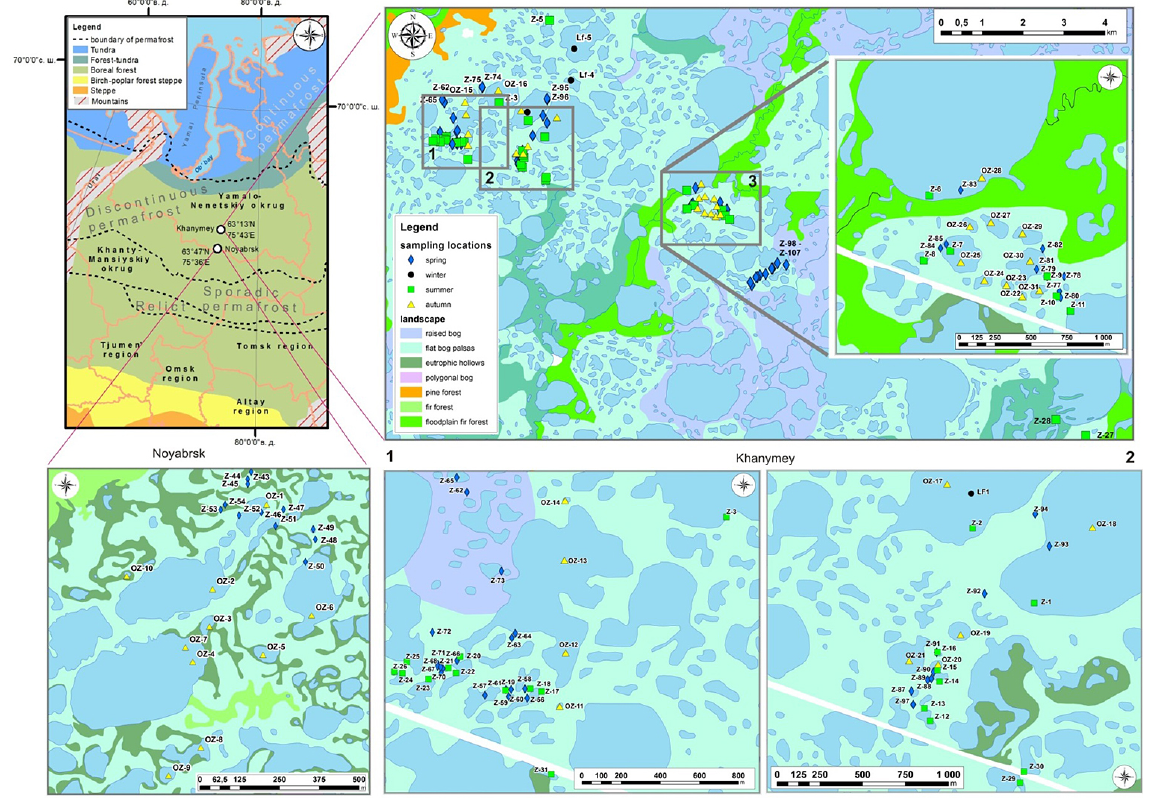
Figure 1. Study site area with symbols showing the position of sampled lakes and small water bodies in different seasons. Different colors correspond to different elementary